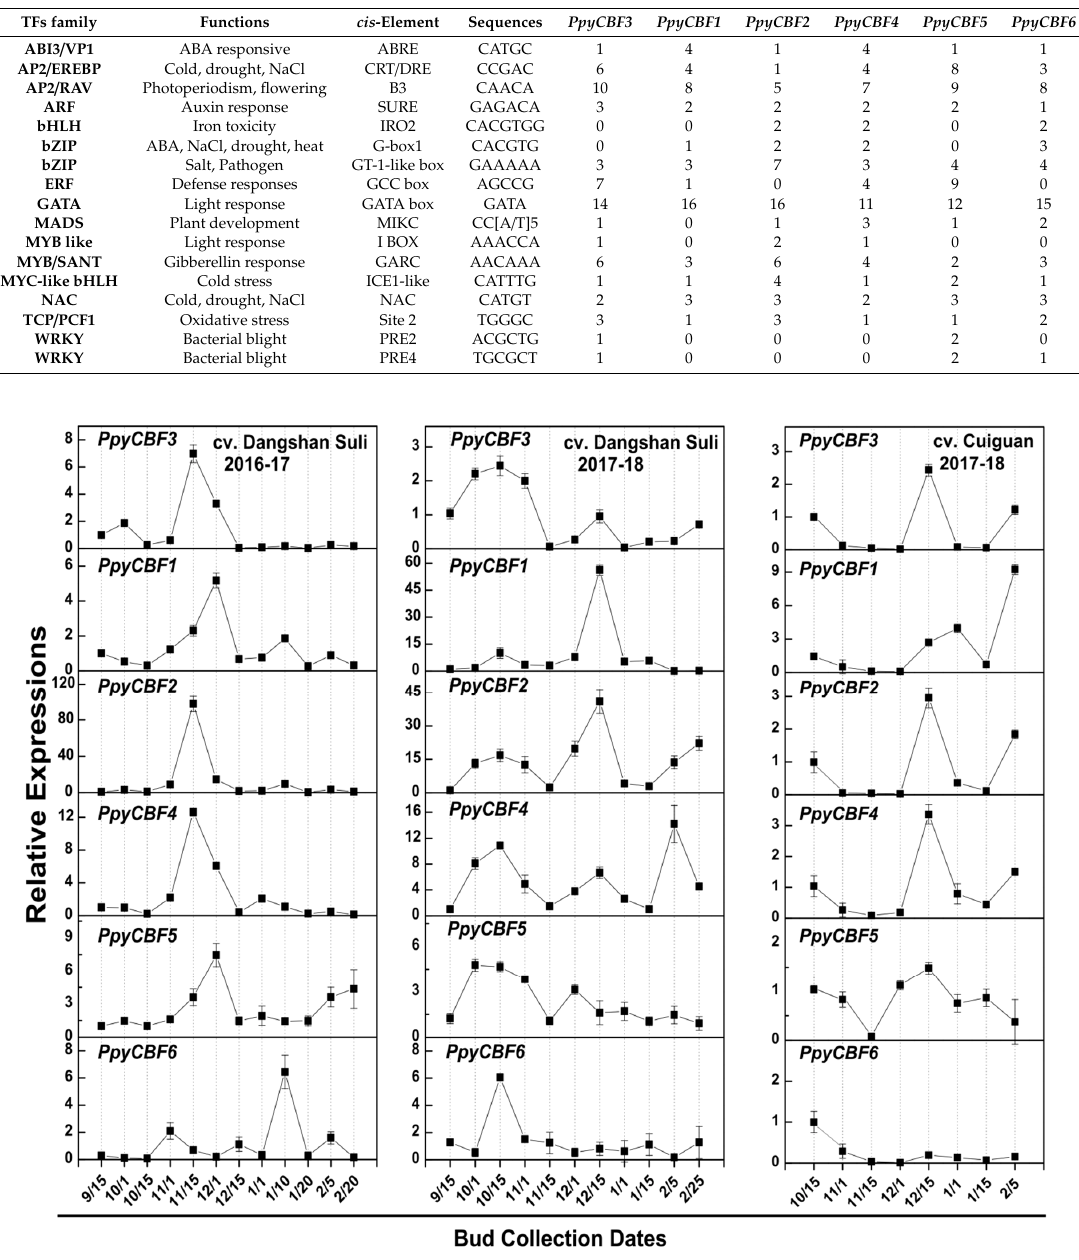
Figure 3. Relative expressions of PpyCBFs during bud endodormancy in Pyrus pyrifolia cv. ‘Dangshan Suli’ and ‘Cuiguan’ during two successive years 2016–2017 and 2017–2018. Buds were collected from September 15 to February 25 with about 15-day intervals. The data were normalized to PpyActin levels and the mean expression value was premeditated from four independent replicates. The standard deviation was shown by vertical bars.